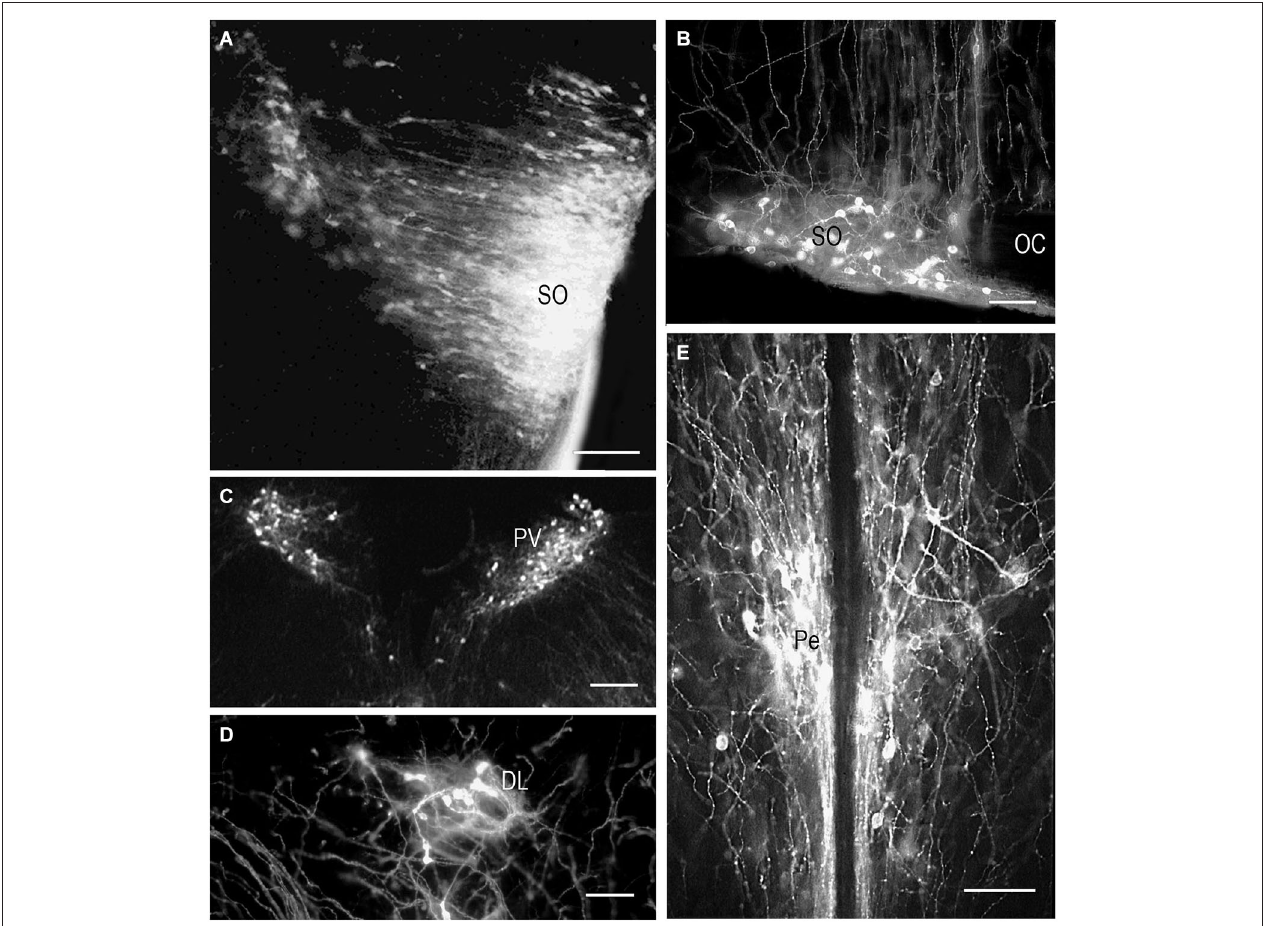
(SO) and wide space of the anterior hypothalamus. (B) E20, magnocellular neurons in SO. (C) E19, magnocellular neurons in the paraventricular nuclei (PV). (D) P9, neurons in the dorsolateral accessory nucleus. (E) P10, neurons in the periventricular hypothalamic nucleus after DiI insertion in the intermediate pituitary lobe. Scale bars = 100 µ